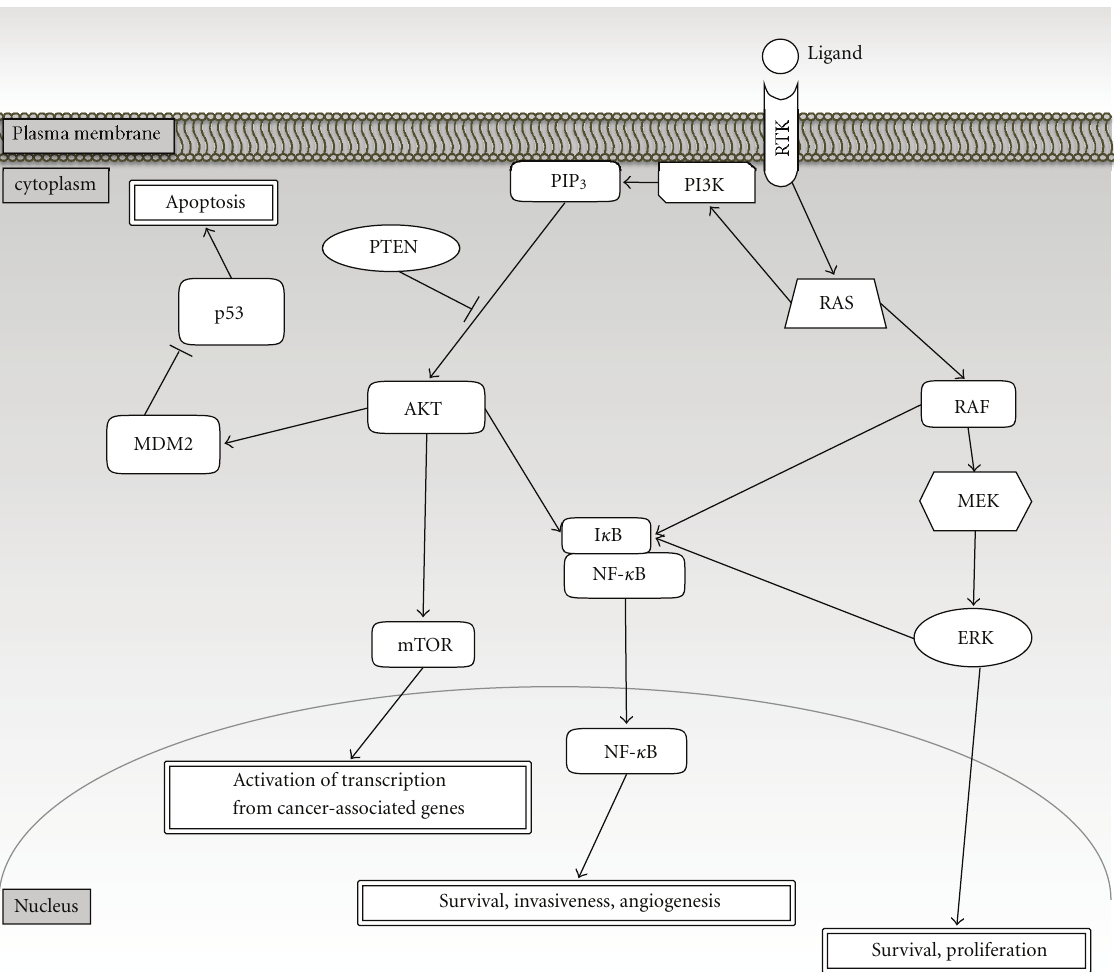
Figure 1: Signal transduction in melanoma development and progression. Extracellular signaling (ligand) triggers intracellular signaling through receptors such as tyrosine kinases (RTK). Triggered signals are transduced via verious factors, including tyrosine kinases, phos- phatases, inhibitors, cofactors, and transcription factors and a ff ect melanoma development and progression. Abbreviations: AKT thymoma viral proto-oncogene; MDM2 transformed mouse 3T3 cell double minute 2; mTOR mechanistic target of rapamycin; PI3K Phosphoinositide 3-kinase, PIP 3 , Phosphatidylinositol (3, 4, 5)-trisphosphate; PTEN phosphatase and tensin